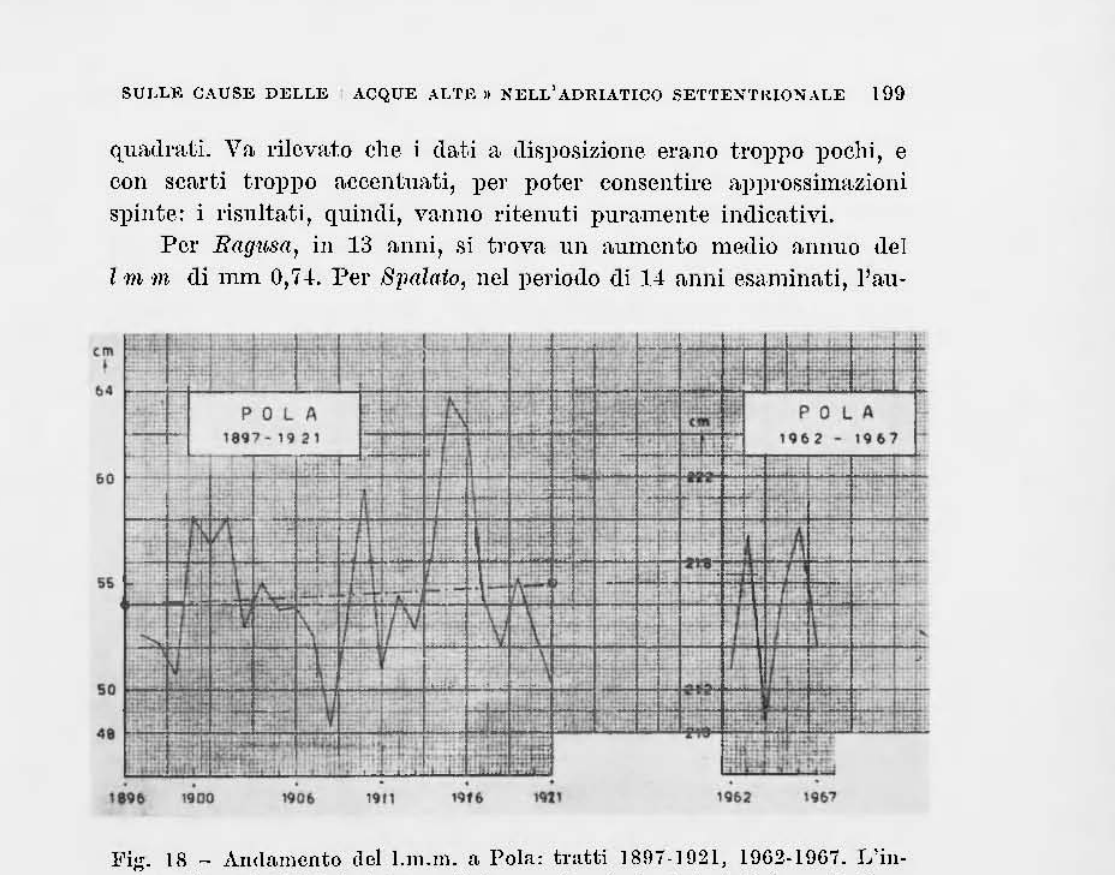
Fig. 18 - Devclopment of mean sea levcl at l'ola for thc intcrvals 1897 to U)21 anl1 19li2·1967. The ftL"st intcrval haR heen averageù aft.cr thc met.h0l1 of